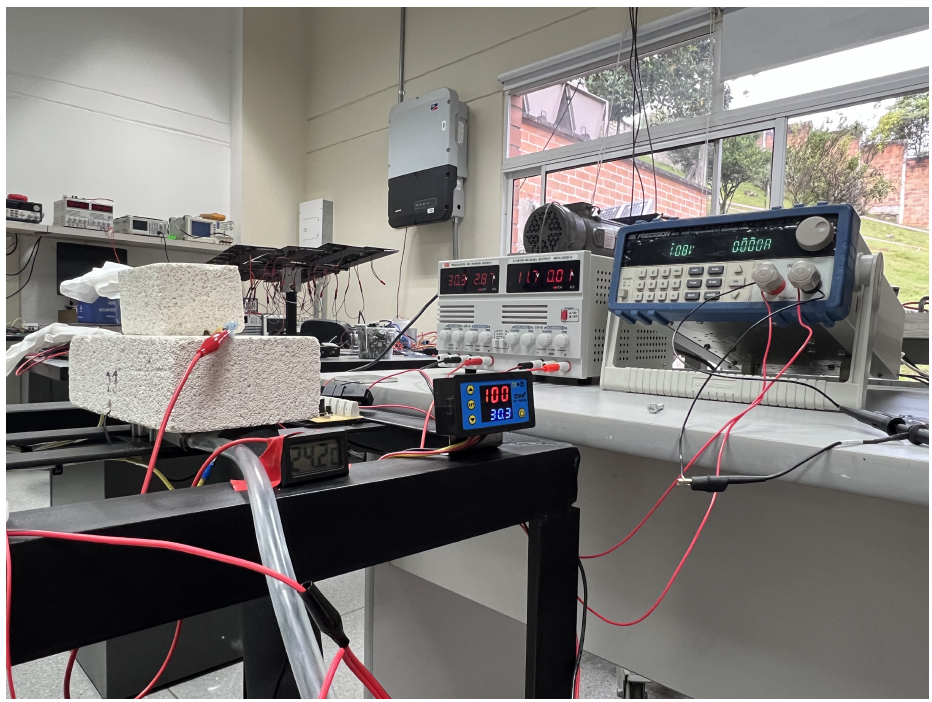
Figure 3. Experimental setup to measure the electric response of the TEG module under different boundary thermal